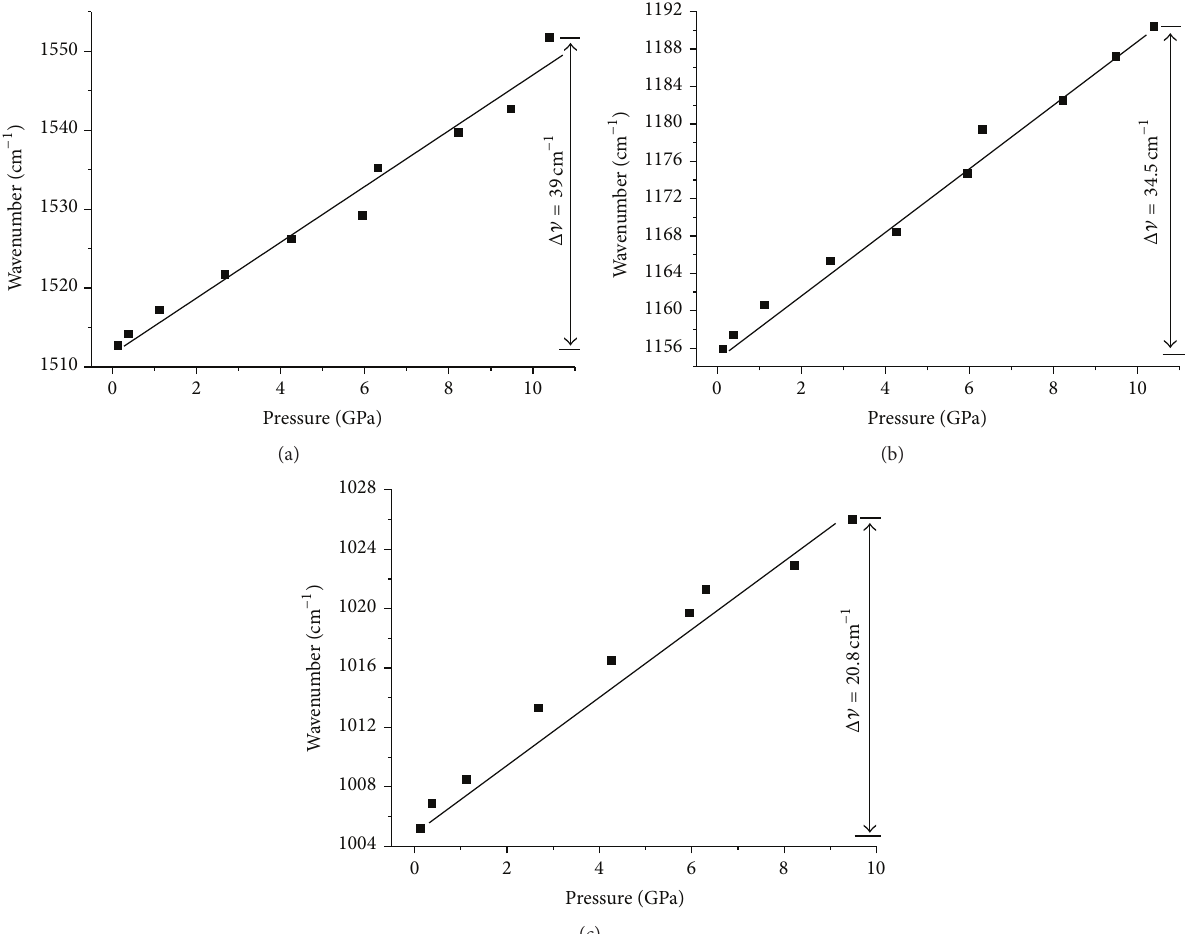
Figure 4: Pressure dependence of (a) ] 1 , (b) ] 2 , and (c) ] 3 frequencies of